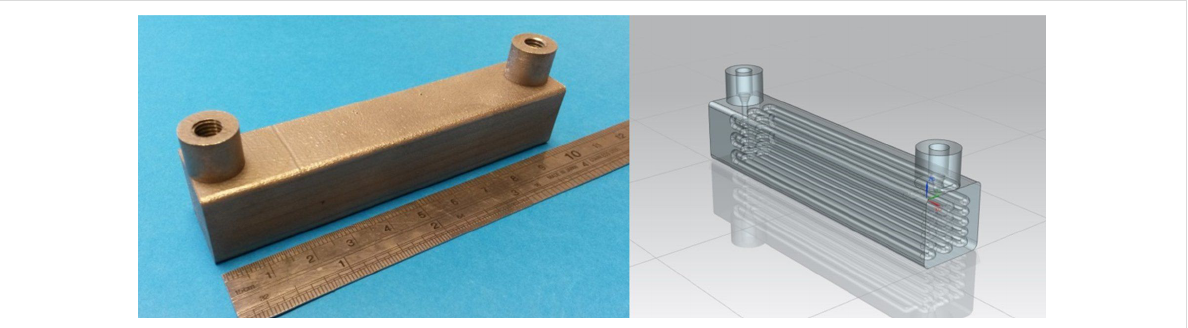
Figure 6: SLM reactor RD2 (left), CAD model of RD2 (right). External dimensions of RD2 are 100 (length) × 20 (width) × 20 mm (depth).